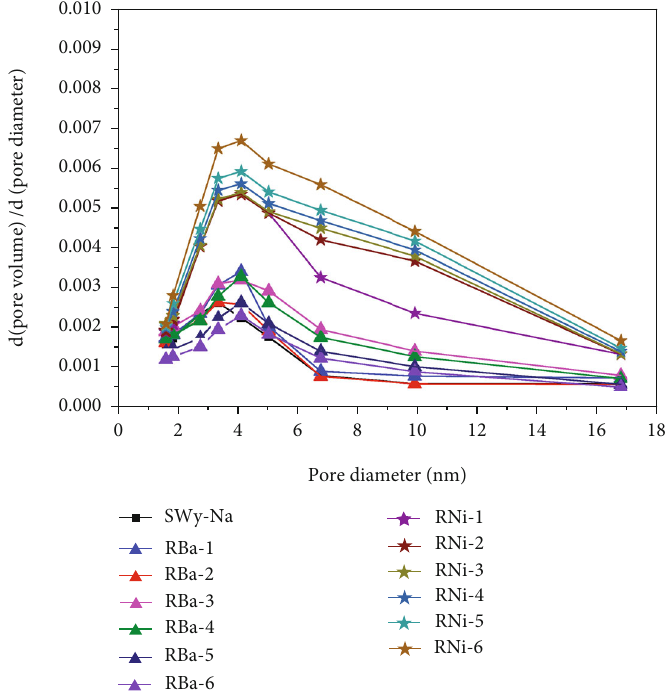
Figure 9: The derivative pore size distribution